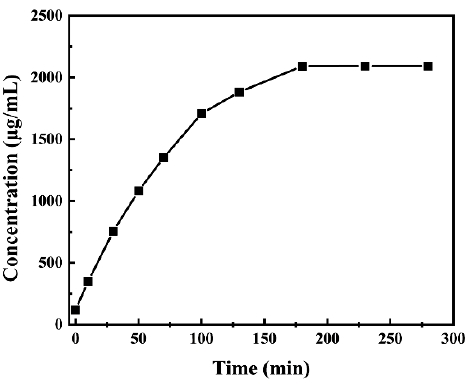
Figure 4. Slow-release process of Cefalexin@MSNs.